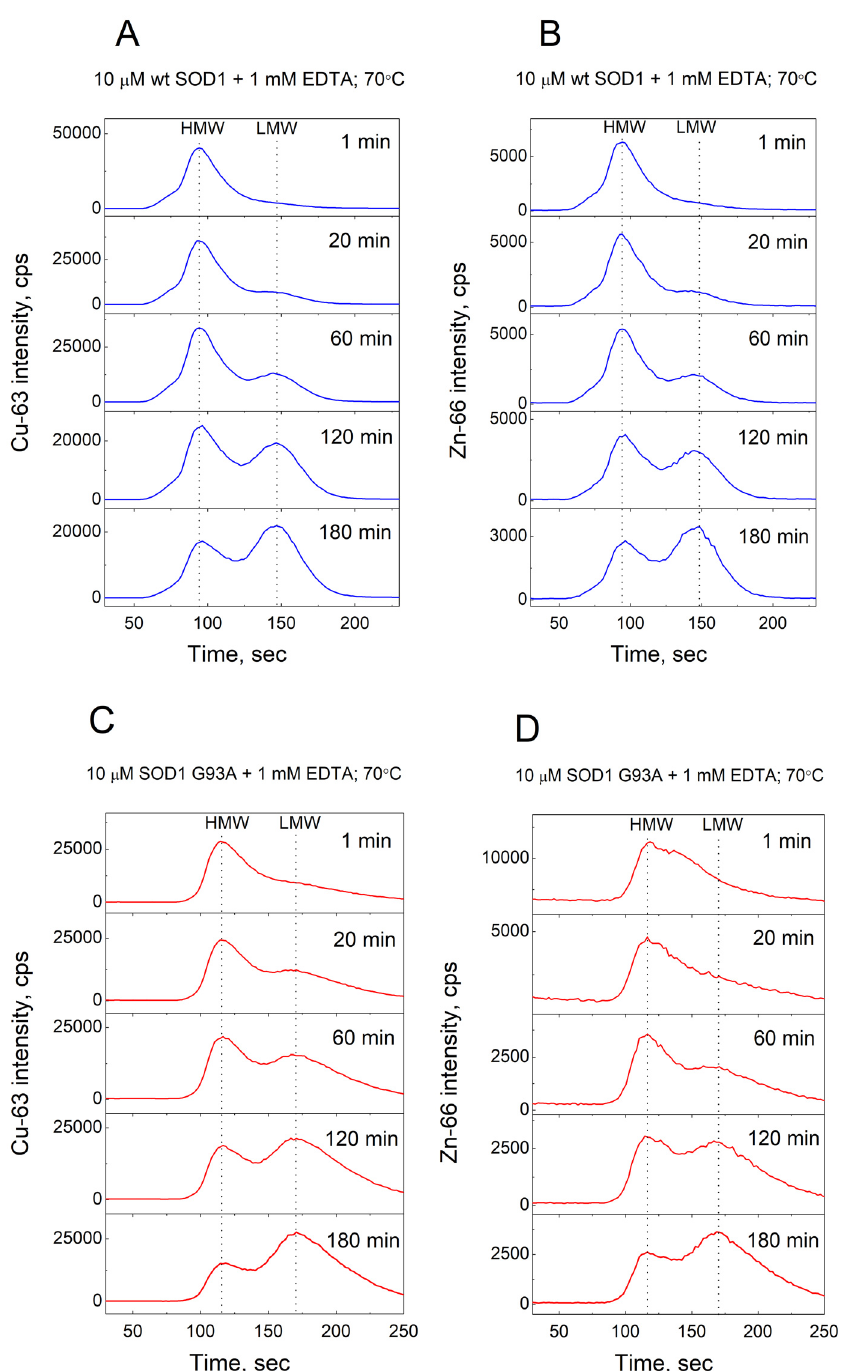
Figure 2. Demetallation of wt and G93A mutant Cu,Zn-SOD1 monitored by LC-ICP-MS. Conditions: 10 µ M wt Cu,Zn-SOD1 ( A , B ) and 10 µ M of its G93A mutant ( C , D ) in the presence of 1 mM EDTA at 70 ◦ C in 50 mM HEPES/50 mM NaCl, pH 7.3. The separation of the HMW and LMW peaks allows integration using Origin software. Kinetic curves reflecting a decrease of the fractional content of metalated protein in time are presented in Figure